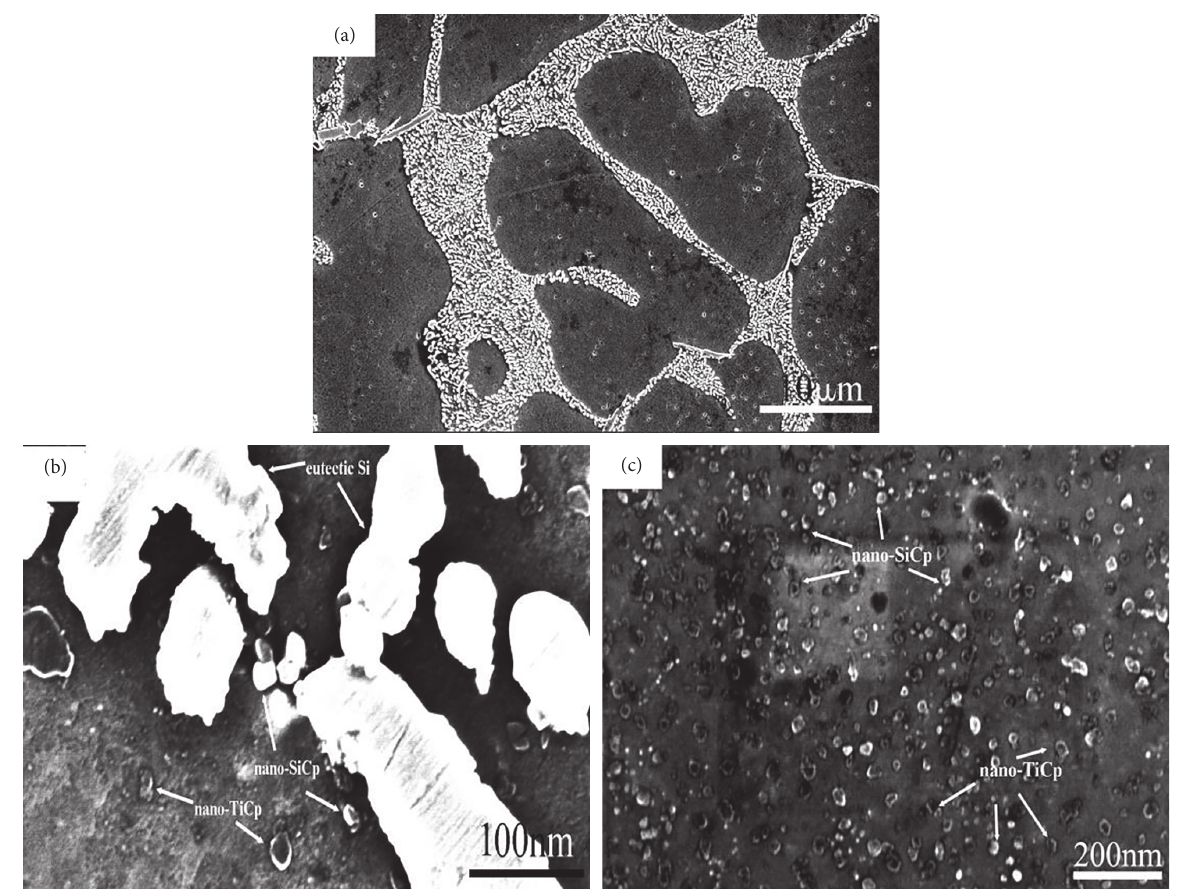
Figure 4: Scanning electron microscope (SEM) of 2 vol% hybrid nano-(SiCp +TiCp)/Al composites. (a) Low magnification; (b) eutectic silicon and α -Al phase; (c) α -Al